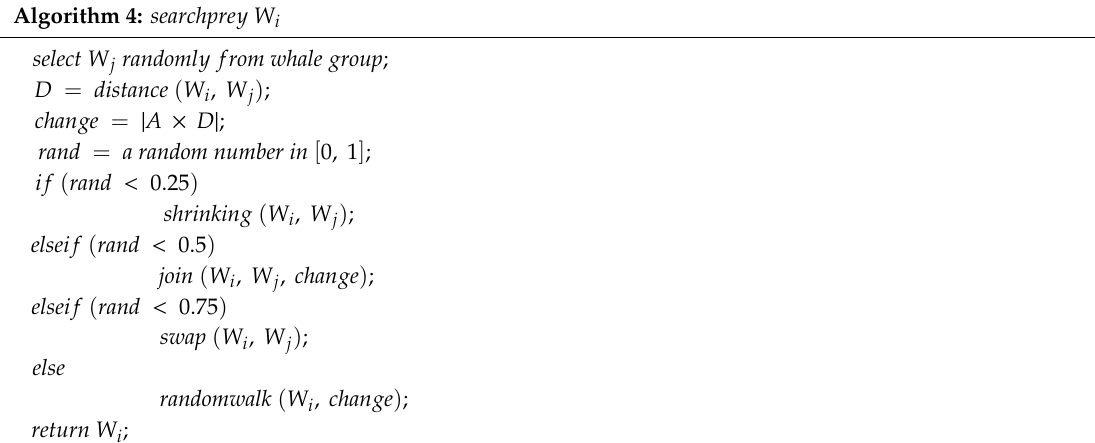
Algorithm 4: searchprey W i